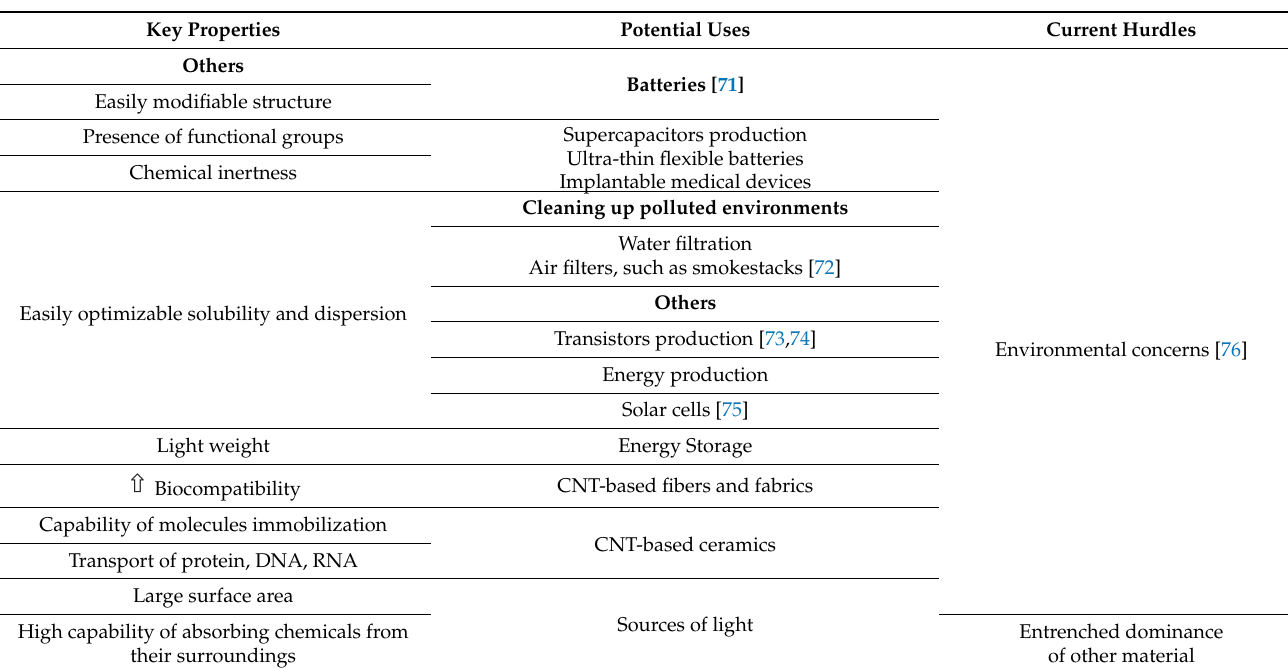
Table 2. Cont. Table 5. The three most applied methods to synthetize CNTs.